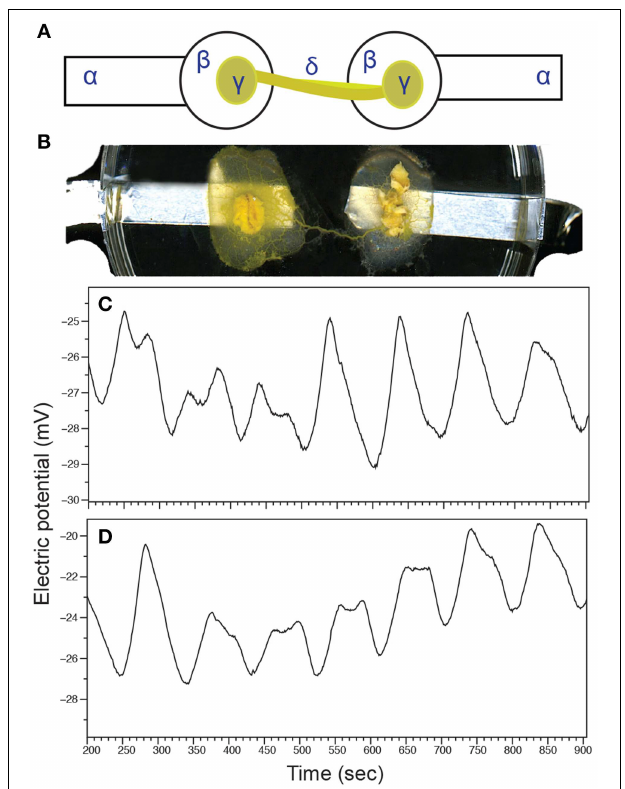
FIGURE 6 | The electrophysiological response to V. officinalis hairy root culture in a simple plasmodium circuit. (A) Schematic representation of the experimental circuit for measuring P. polycephalum surface electrical activity. Plasmodium was inoculated onto agar blobs situated on aluminum electrodes. Completed circuits with a single protoplasmic tube spanning both agar blobs were used for electrical activity recording. α , aluminum electrode; β , agar blob; γ , plasmodium-colonized oat flake; δ , protoplasmic tube. (B) Photograph of an intact experimental circuit. A solitary protoplasmic tube connects two agar blobs situated on recording electrodes. (C) Exemplary patterns of electrical oscillations of undisturbed plasmodium. (D) Exemplary oscillation patterns of electrical activity after the introduction of VoHR5 hairy root culture